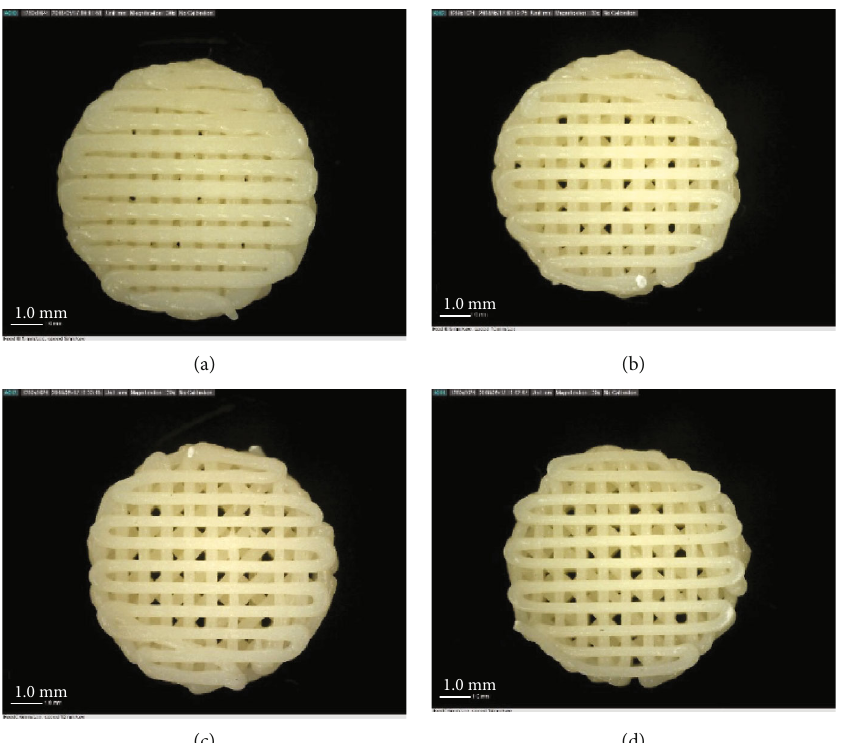
Figure 3: The 50/50 PCL/PHBV sca ff olds fabricated using the hatch speeds of (a) 8, (b) 10, (c) 12, and (d) 14 mm/s under a constant fi lament feeding speed of 0.5mm/s.